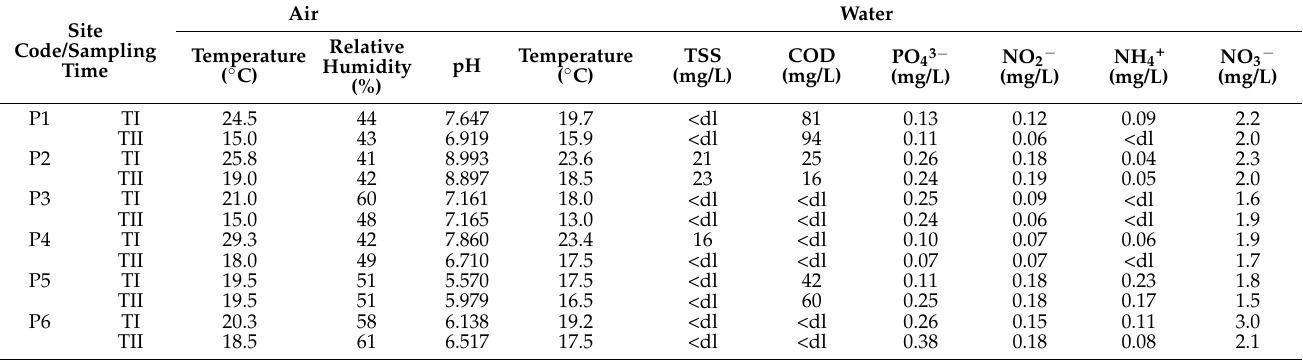
Table 2. Physicochemical analyses in each pond, on two sampling times (September (TI) and October